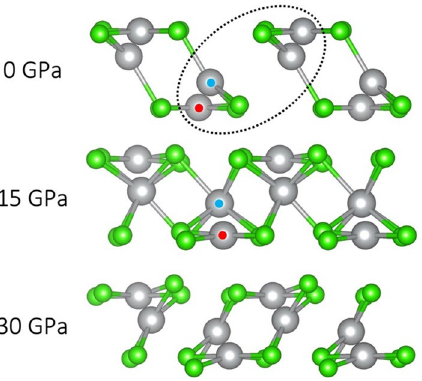
Figure 7. Structural transition of AuCl 2 -type polymorph in the HSE06 picture. Nanotubes are viewed along the axis of propagation. Blue and red circles indicate Ag(I) and Ag(III) species,